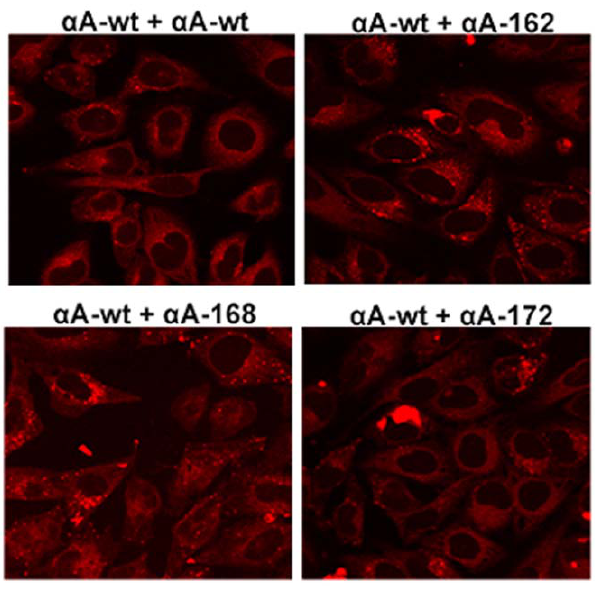
Figure 10. Aggresomes detected in YFP-tagged truncated constructs co-expressed with CFP a Awt. Aggresome foci were still visible in a Awt co-expressed only with a A162 and a A168 constructs but not in co-expression with a Awt and a A172 constructs.